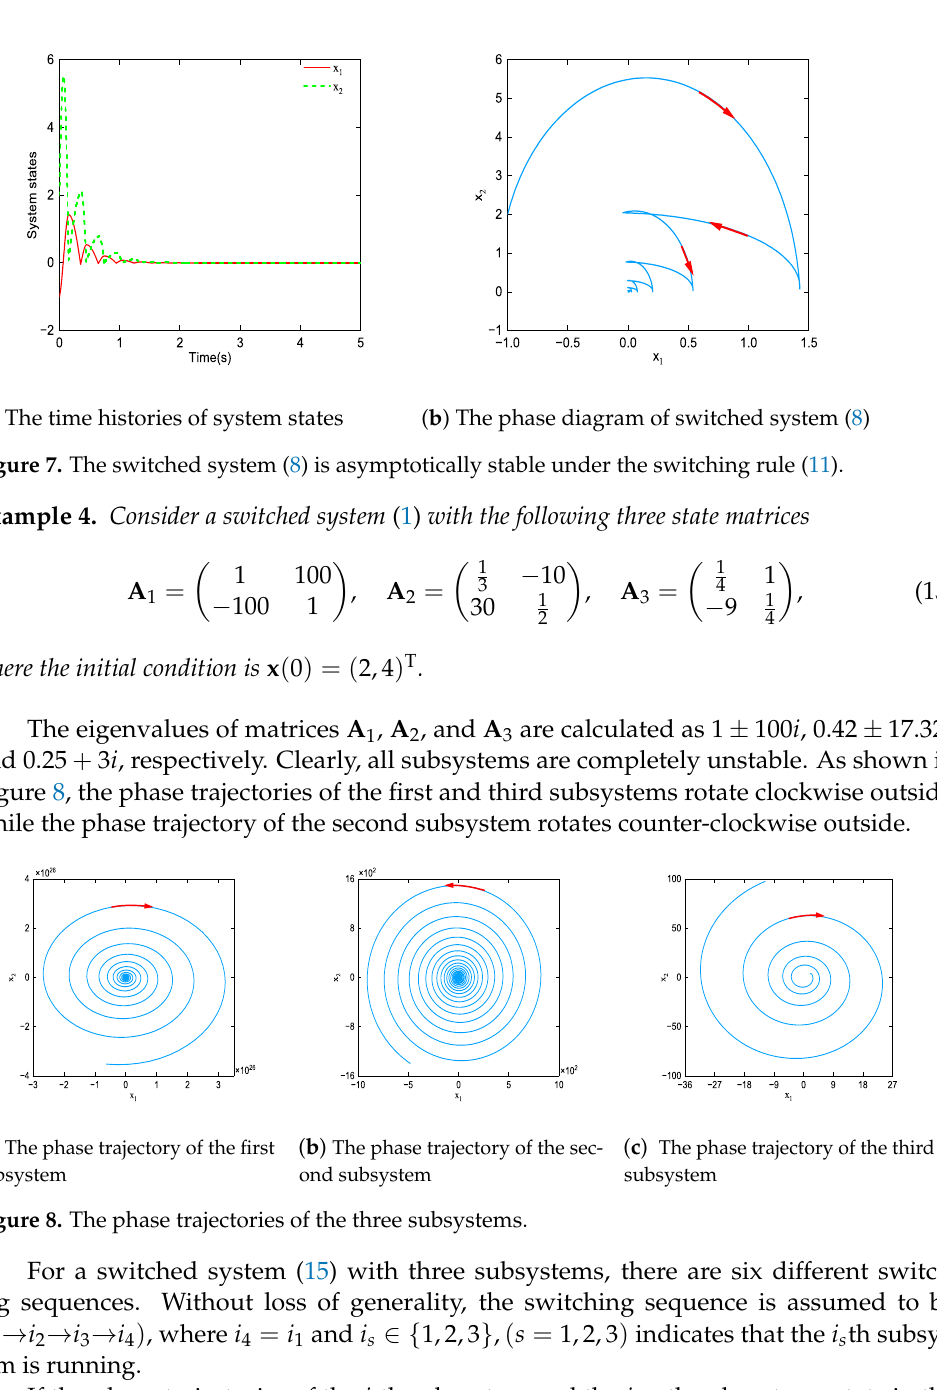
( c ) The phase trajectory of the third